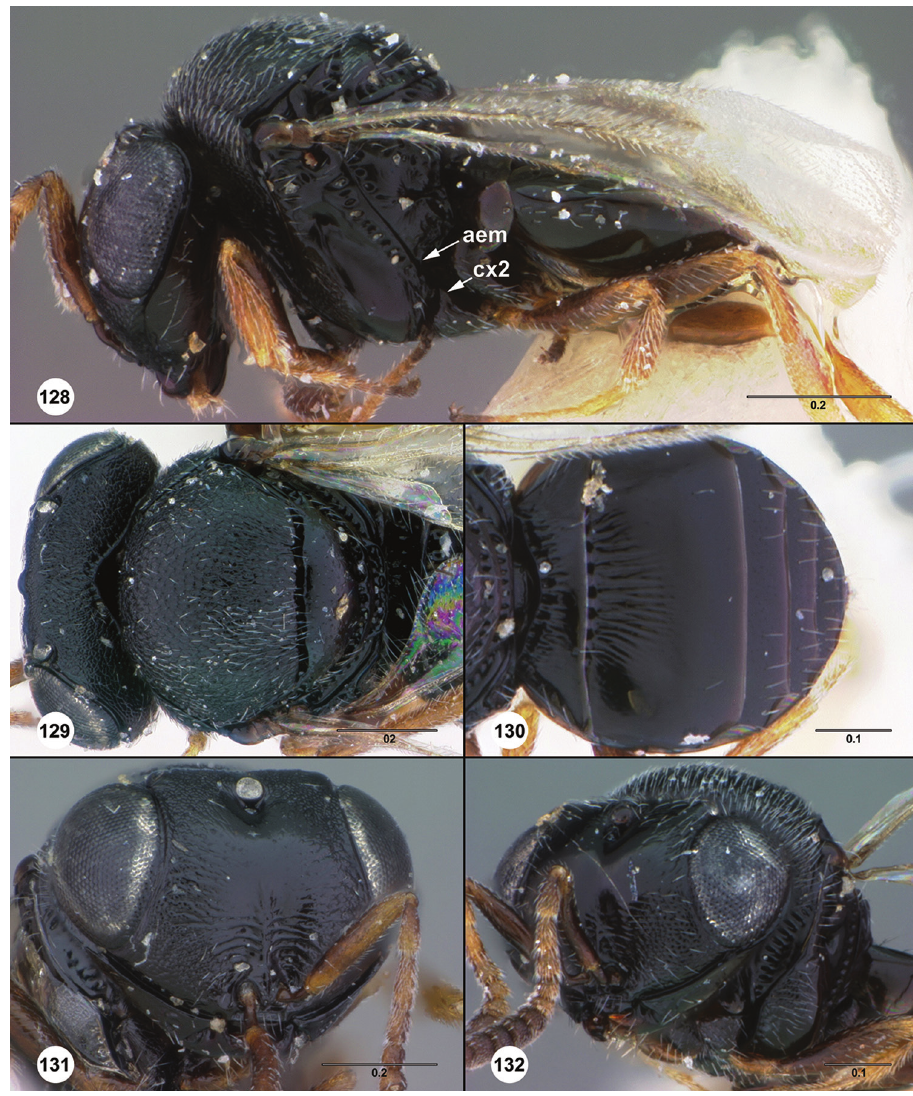
Figures 128–132. T. perepelovi 128 female paratype (USNMENT00916339), head, mesosoma, meta- soma, lateral view 129 female paratype of T. dircus syn. n. (USNMENT00916278), head and meso- soma, dorsal view 130 female paratype (USNMENT00916338), mesosoma, dorsal view 131 female paratype of T. dircus syn. n. (USNMENT00916278), head, anterior view 132 female paratype (USN- MENT00916338), head, anterolateral view. Scale bars in